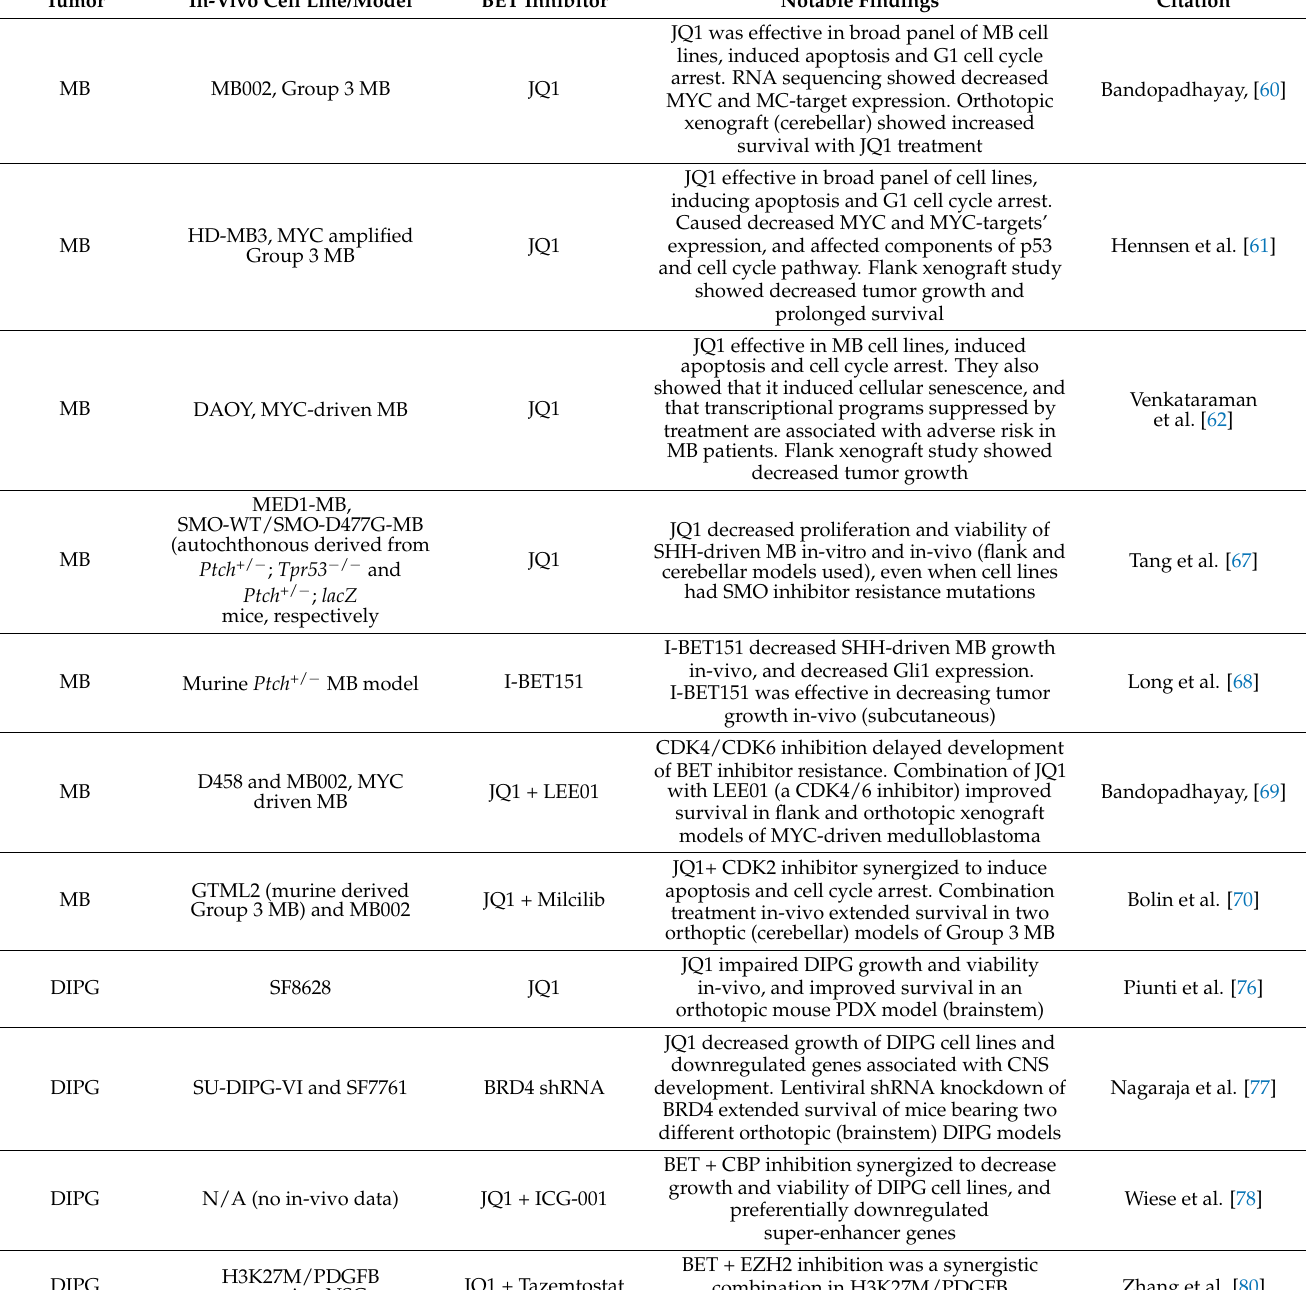
Table 2. Findings from pre-clinical studies of BET inhibitors in pediatric brain tumor